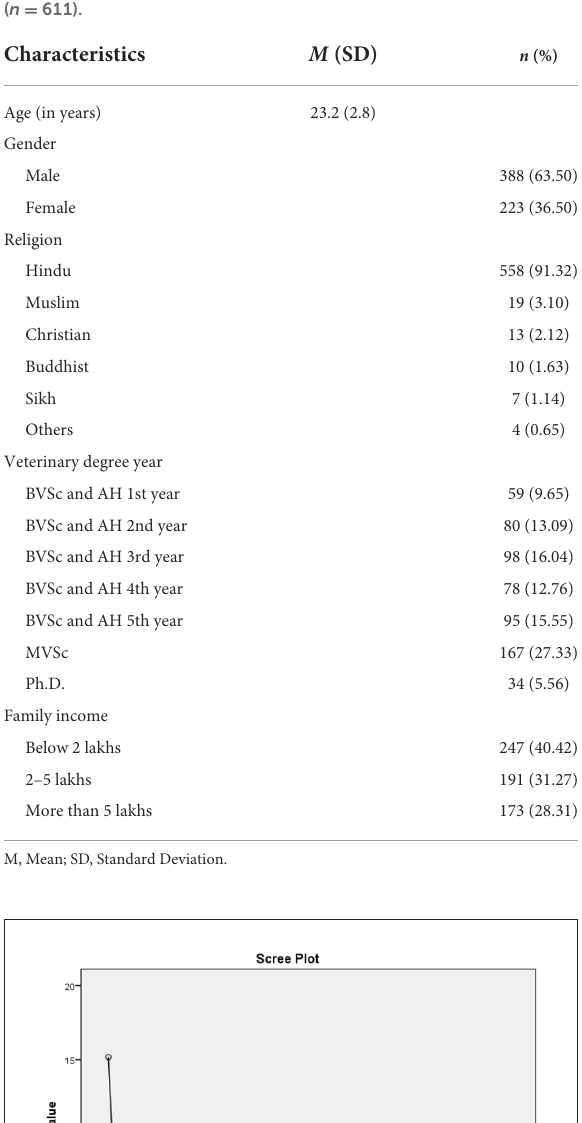
TABLE 1 Socio-demographic characteristics of the participants ( n = 611).